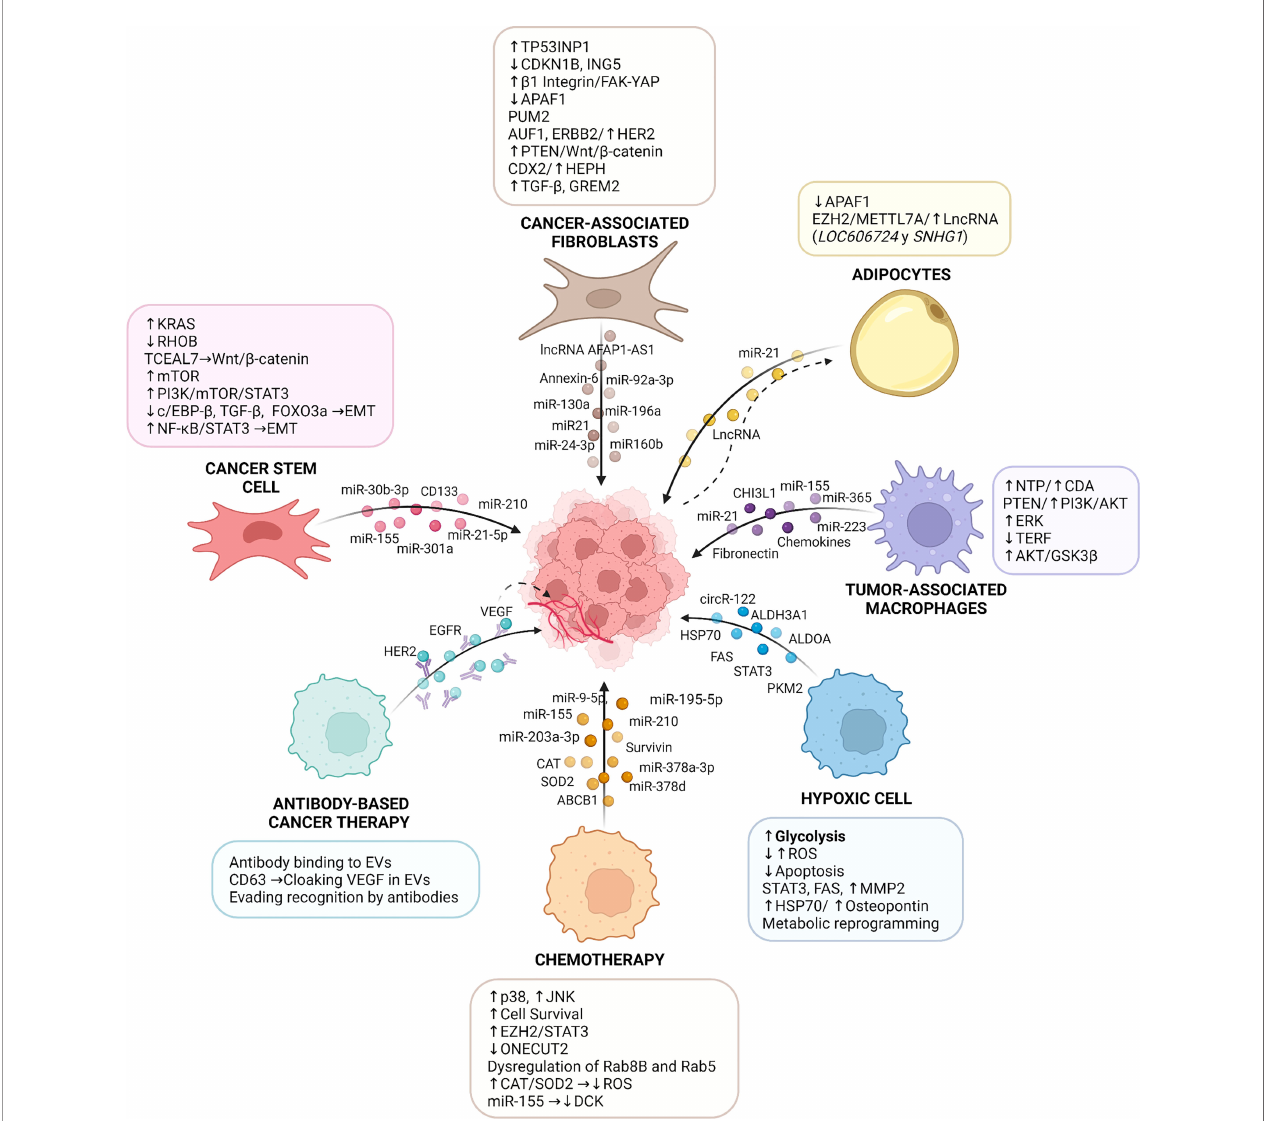
FIGURE 1 | Role of Extracellular Vesicles in Cancer Therapy Resistance. The tumor microenvironment (TME) is involved in the initiation and maintenance of resistance to therapies by multiple molecular mechanisms. Speci fi cally, extracellular vesicles derived from TME cells (e.g., cancer-associated fi broblasts, endothelial cells, cancer stem cells, immune cells, and adipocytes) transfer a variety of bioactive molecules, including mRNA, miR, lncRNA and proteins, which all play important roles in the communication between stromal components and tumor cells, activating in the latter signaling pathways that lead to cancer therapy resistance. In addition, resistance to therapy can be triggered by an in fl ammatory TME caused by conditions, such as hypoxia, or following chemotherapy, which modulate the content and release of EVs and alter the responses of tumor cells to cancer therapies. EVs also participate in resistance to antibody-based cancer therapy where cancer-derived extracellular vesicles package elevated amounts of validated targets for cancer treatment (e.g., VEGF, EGFR, and HER2), which are recognized by therapeutic antibodies and compromise the response of cancer cells to these therapies. TP53INP1: tumor protein p53 inducible nuclear protein 1; CDKN1B: cyclin- dependent kinase inhibitor 1B; ING5: inhibitor of growth family 5; FAK: focal adhesion kinase; YAP: yes-associated protein 1; PUM2: pumilio homolog 2 protein; AUF1: AU-binding factor 1; HER2: human epidermal growth factor receptor 2; CDX2: caudal ‐ related homeobox 2; HEPH: hephaestin; TGF- b : transforming growth factor b ; GREM2: gremlin 2; APAF-1: apoptotic peptidase activator factor 1; RHOB: ras homolog family member B; TCEAL7: transcription elongation factor A-like 7; mTOR: mammalian target of rapamycin; PI3K: phosphoinositide-3-kinase; STAT3: signal transducer and activator of transcription 3; c/EBP- b : CCAAT enhancer binding protein- b ; FOXO3a: forkhead box O3a; EMT: epithelial-mesenchymal transition; AFAP1-AS1: actin fi lament associated protein 1 antisense RNA 1; EZH2: enhancer of zeste homolog 2; METTL7A: methyltransferase like 7A; LncRNA: long noncoding RNA; SNHG1: small nucleolar RNA host gene 1; NTP: triphosphate- nucleotide; CDA: cytidine-deaminase; TERF: telomeric repeat-binding factor 1; GSK3 b : glycogen synthase kinase 3 b ; ROS: reactive oxygen species; FAS: fatty acid synthase; HSP70: heat shock 70 kDa protein; ONECUT2: factor One Cut Homeobox 2; ABCB1: ATP-binding cassette sub-family B member 1; CAT: catalase; SOD2: superoxide dismutase 2; DCK: deoxycytidine kinase; EGFR: epidermal growth factor receptor; VEGF: vascular endothelial growth factor; ALDH3A1: aldehyde dehydrogenase 3 family member A1; ALDOA: aldolase A; CHI3L1: chitinase 3-like-1. The fi gure was created with